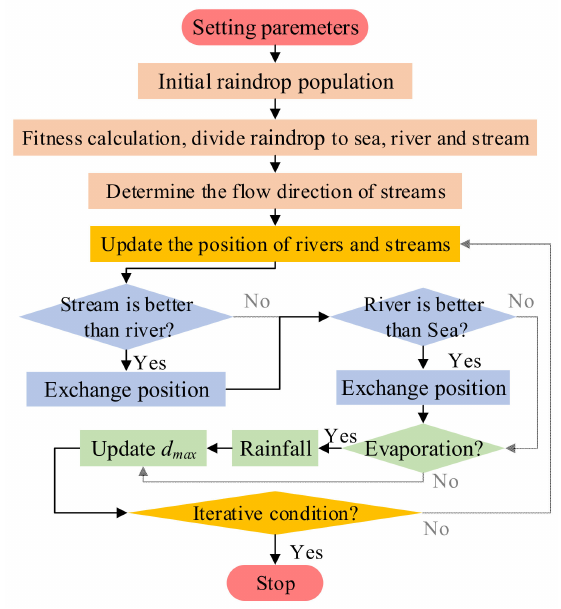
Figure 7. Flow chart of the